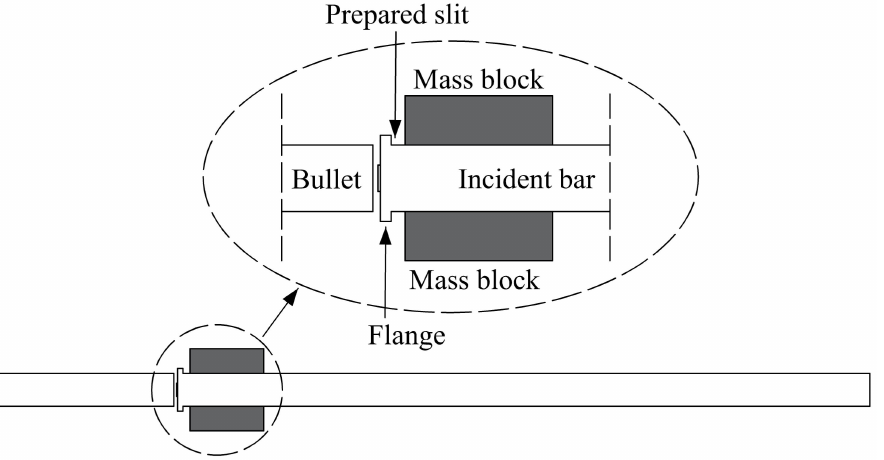
Figure 7. Schematic diagram of single-loading